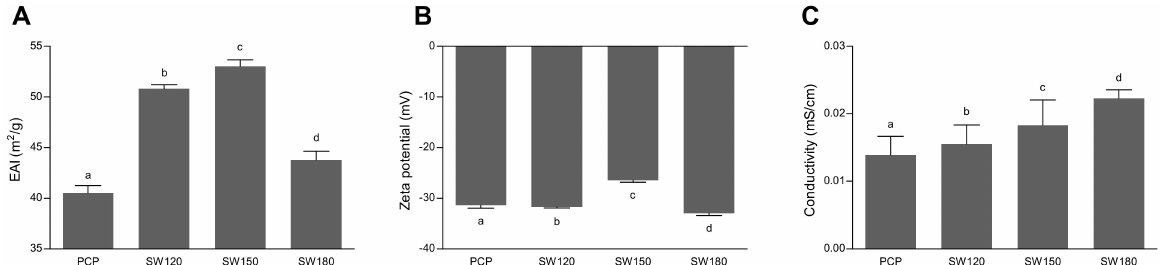
Figure 3. Emulsifying activity ( A ), Zeta potential ( B ), and Conductivity ( C ) of polysaccharides emulsions under different SCW conditions. Data were expressed by means ± SD ( n = 3). Values in the same column with different letters are significantly different ( p < 0.05). PCP, pumpkin crude polysaccharides; SW120, PCP under SCW 120 ◦ C treatment; SW150, PCP under SCW 150 ◦ C treatment; SW180, PCP under SCW 180 ◦ C